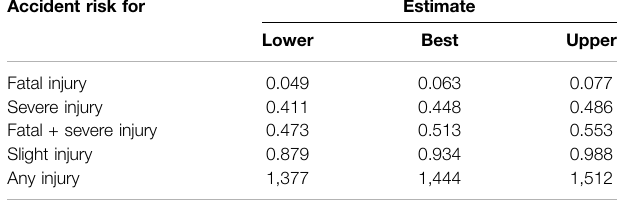
TABLE 3 | Total risk estimates. Accident risk for